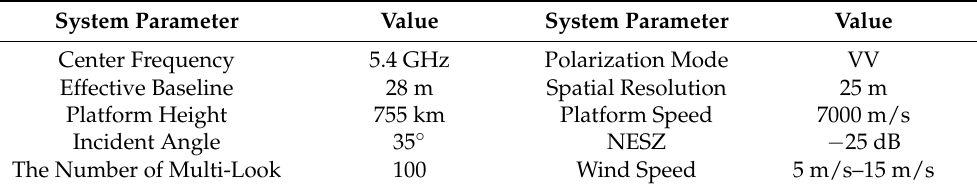
Table 2. System simulation